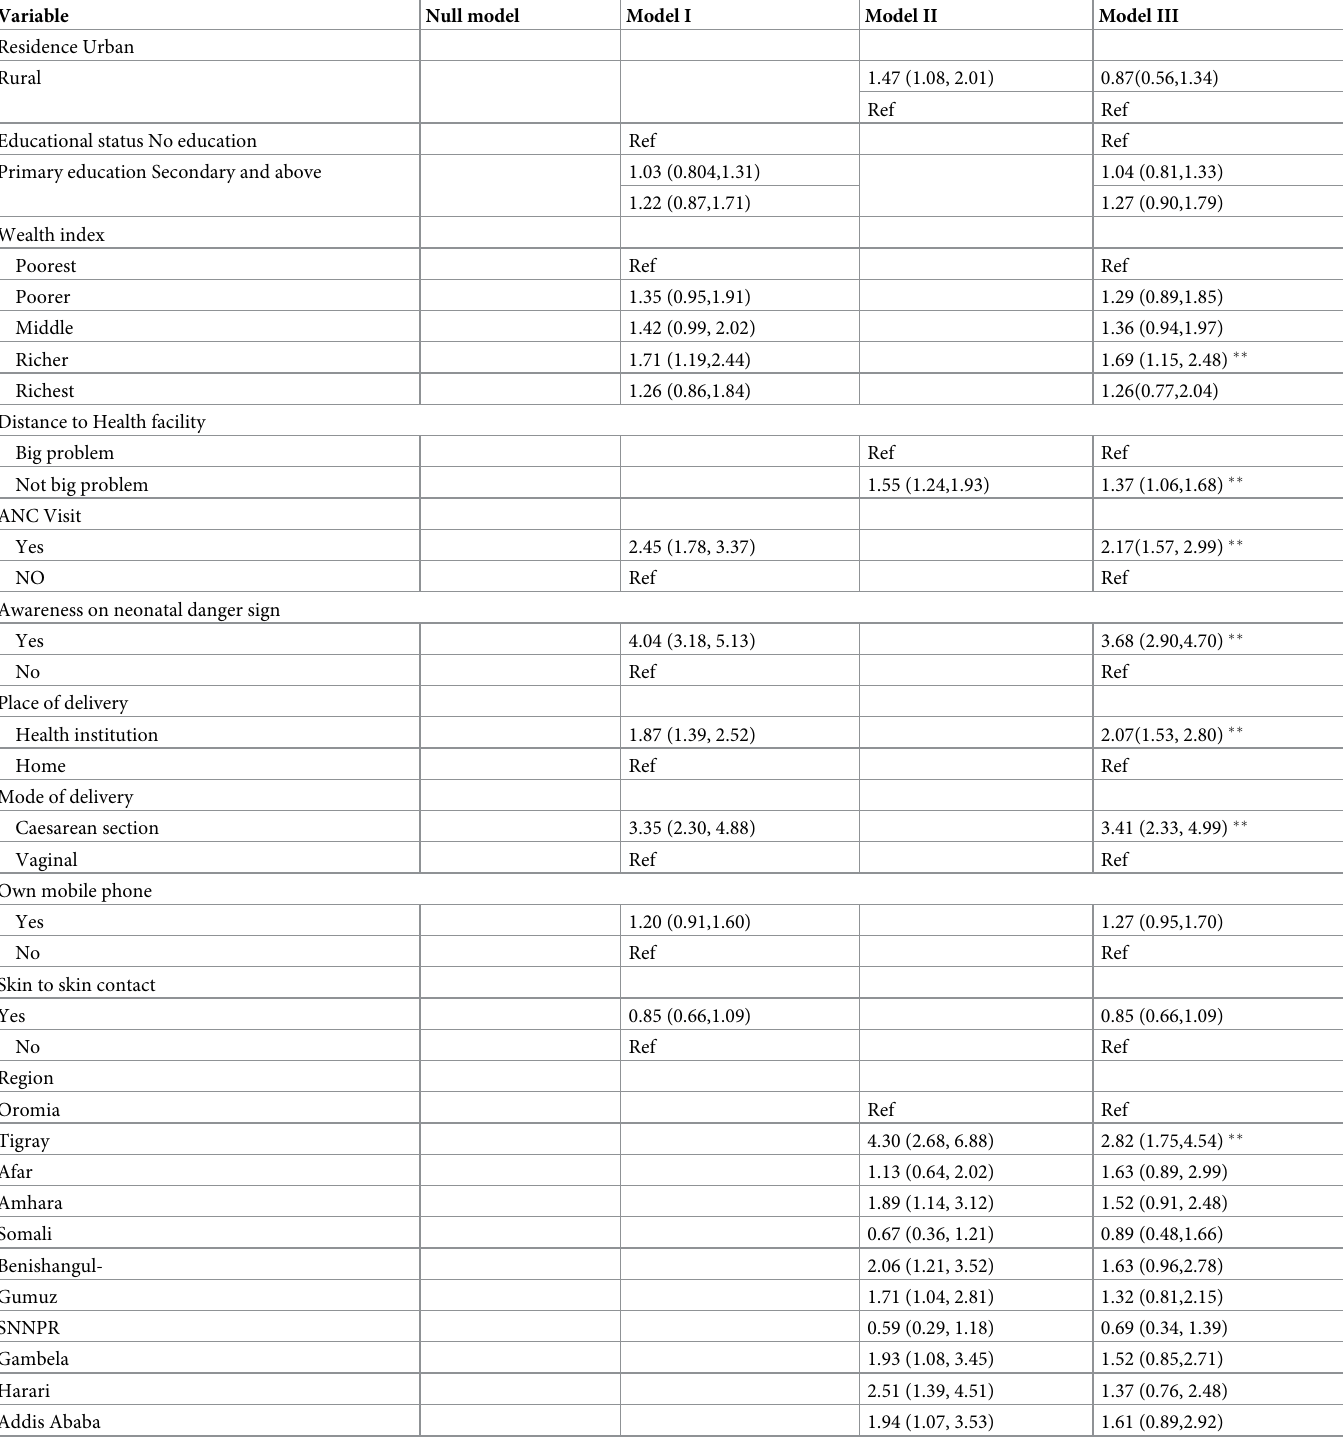
Table 3. Determinants of home based postpartum care by health care providers among postpartum women in